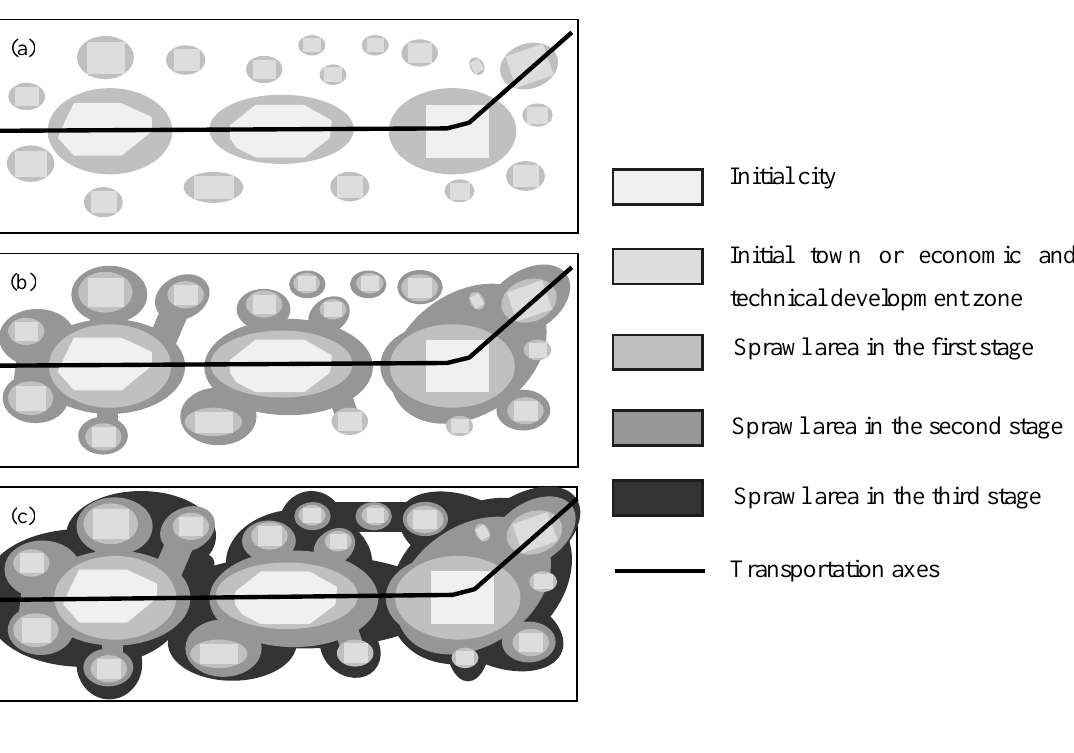
Figure 11. Urban sprawl patterns in the developed area of China at different stages since reform and opening-up: from an individual city to a big urban group or an urban